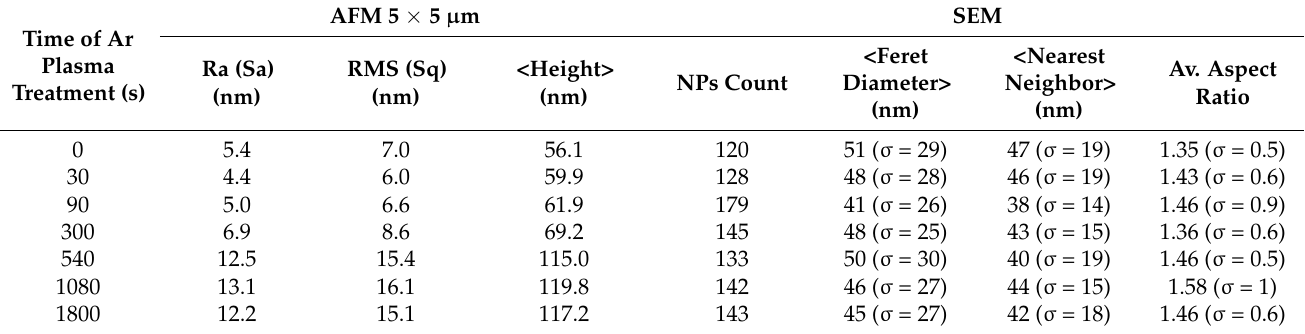
Figure 3. ( a )Two-dimensional AFM height images, ( b ) height distribution profiles (AFM analysis using the Gwyddion software), and ( c ) surface mean roughness (Sa), root mean square roughness (Sq), and mean height (<height>) of the Au:CuO thin films as a function of Ar plasma treatment time. Table 1. Surface properties of the Au:CuO thin films extracted from AFM and SEM studies after different plasma treatment